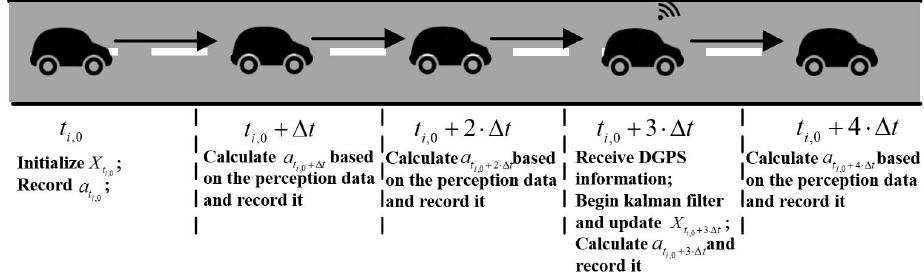
Figure 2. Vehicle state update